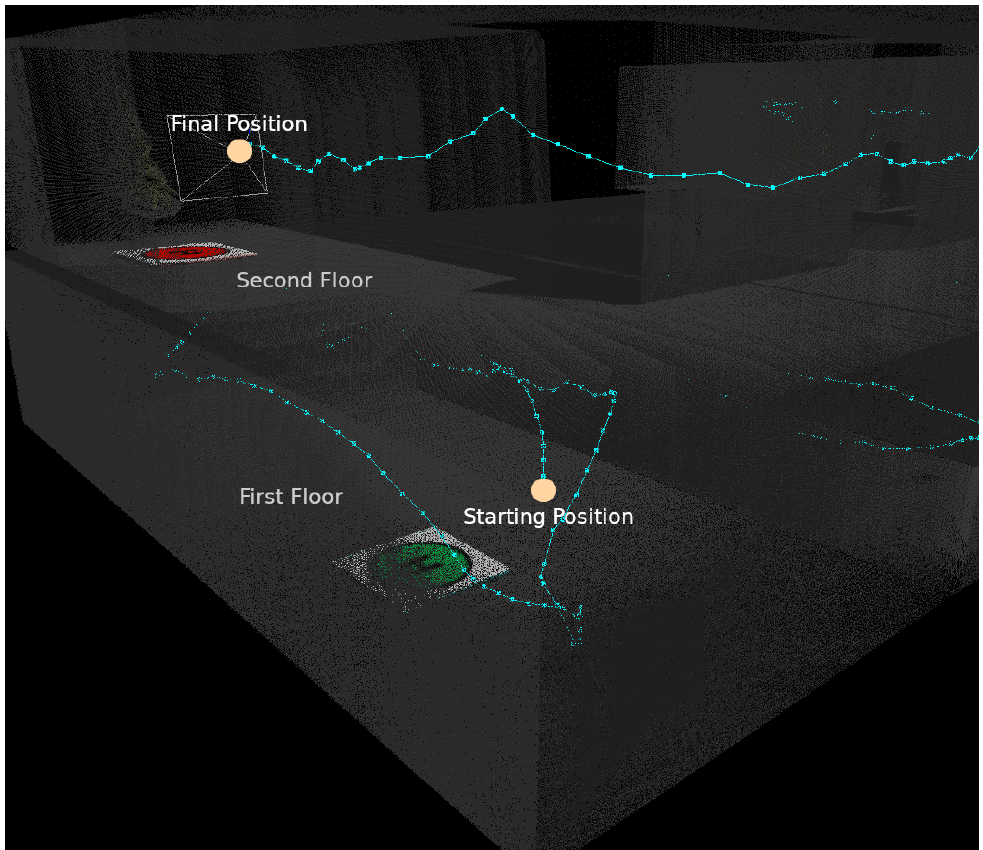
Figure 33. This figure illustrates parts of the trajectory of the UAV related to the start and end of the unknown